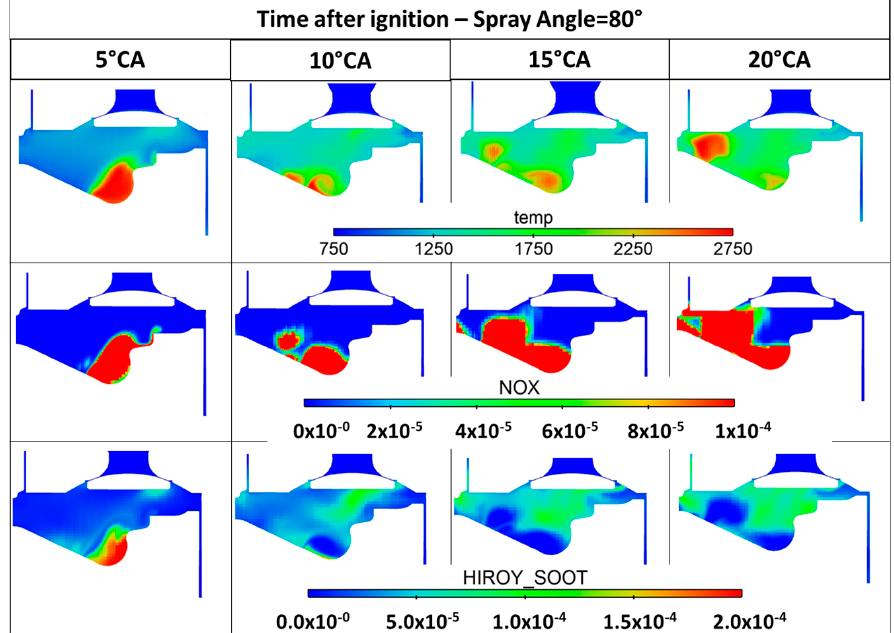
Figure 38. Evolution of in-cylinder temperature, NO x , and soot mass fraction contour plots in a plane formed by the cylinder axis and a spray axis at 5, 10, 15 and 20 °CA after SOIgn for an SIA of 80°.